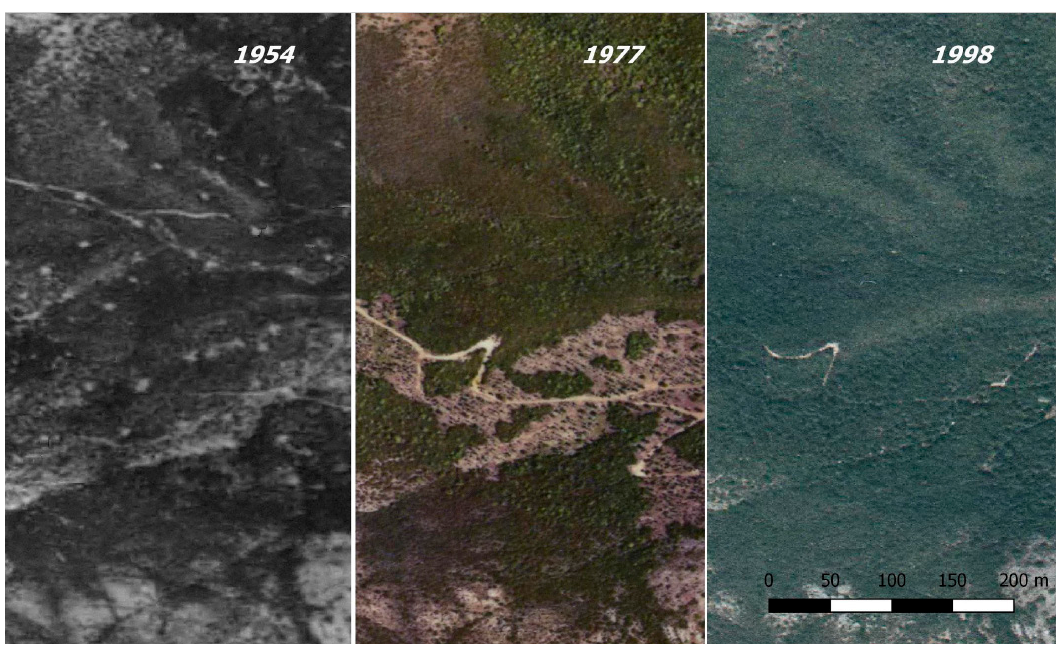
Figure 2. Sequence of images representative of the change in forest management, starting from the intense use in the post-war period to the present day. Mining activities and coal production shaped the landscape of this region and coppice wood dominated the management of this territory since the 19th century, in order to provide coal and lumber for industry, mines, and population. From the photo taken in 1954, it is possible to view the coal areas scattered throughout the territory. In 1977, coppice-with-standards areas at different stages of evolution are evident. Photos with permission from Sardinia Region.